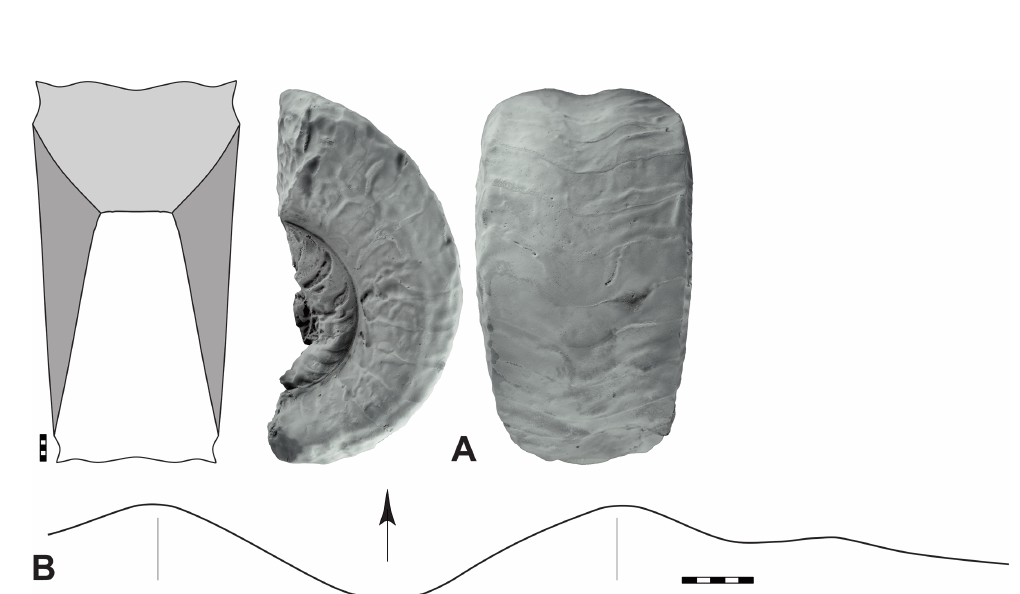
Fig. 22. Vestinautilus sp., specimen MB.C.30475 (Korn et al . 2002 Coll.) from Oued Temertasset. A . Reconstructed dorsal, lateral and ventral views. B . Suture line, at ww = 39.0 mm, wh = 20.5 mm. Scale bar units = 1 mm.